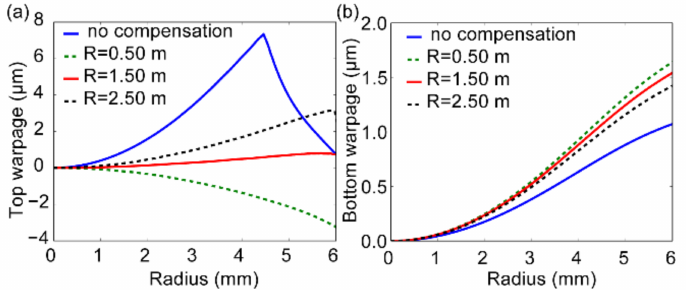
Figure 13. The newly obtained top ( a ) and bottom ( b ) warpage plots under different compensation curvature values.